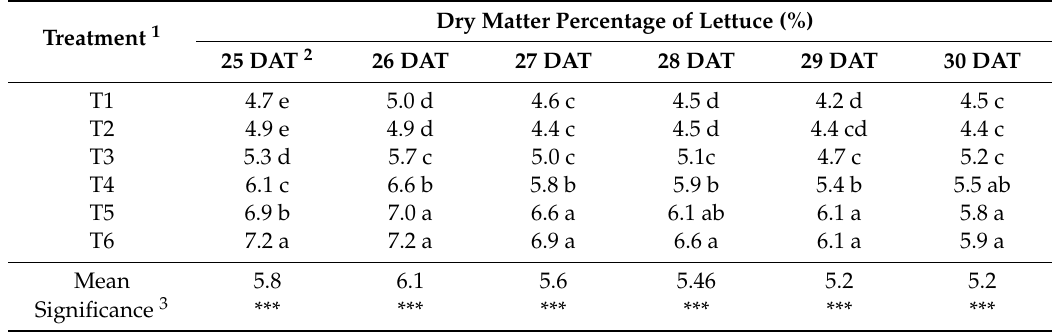
Table 7. Spring trial: dry matter content in lettuce per type of fertilization treatment. Treatment